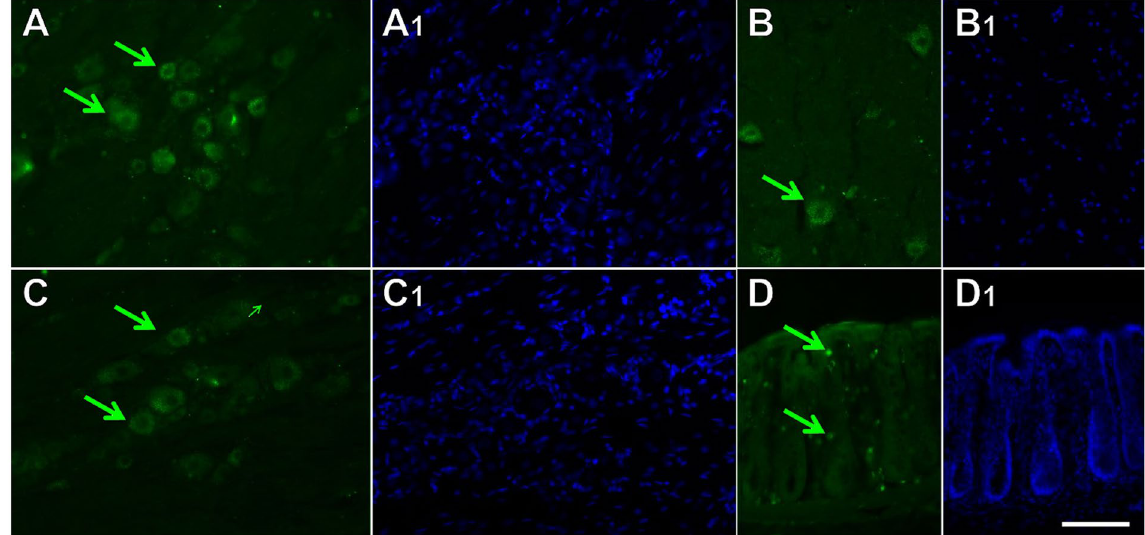
Figure 1. Cryosections of dorsal root ganglion (DRG), trigeminal ganglion (TRG), ventral spinal cord and colon in the rat thirty minutes after intraperitoneal injection of FITC-TAT-4BB. ( A ) FITC-TAT-4BB present in a number of primary afferent sensory neurons in lumbar DRG (green arrows). ( B ) FITC-TAT-4BB present in a number of motor neurons in ventral spinal cord (green arrows). ( C ) FITC-TAT-4BB present in a number of primary afferent sensory neurons in TRG (green arrows). ( D ) FITC-TAT-4BB present in a number of presumptive immune cells based on size and location (green arrows). Nuclei of all cells are stained with DAPI (A 1 , B 1 , C 1 , D 1 blue). Scale bar is 100 μ